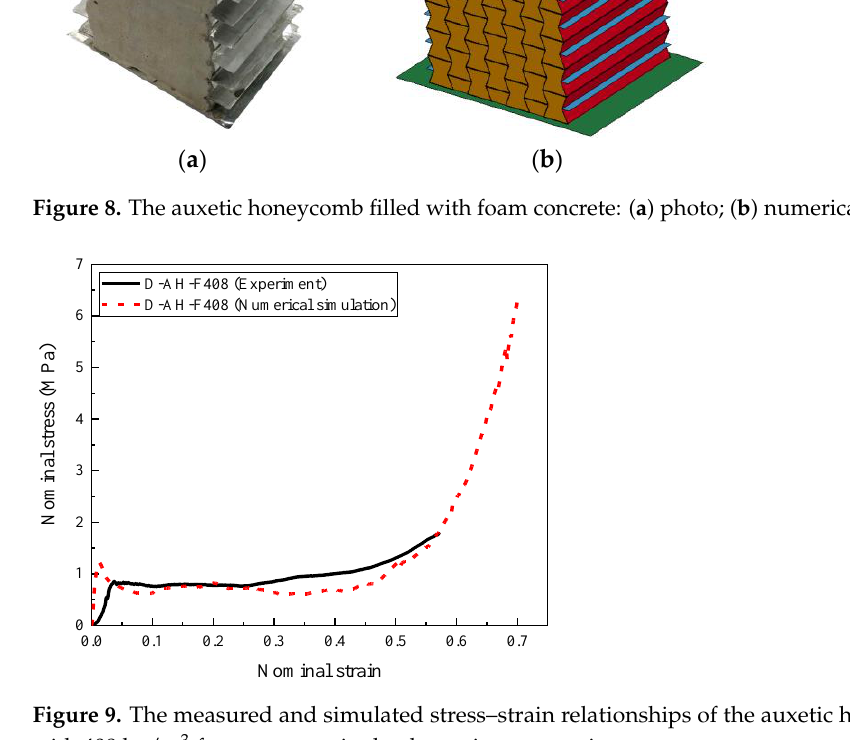
with 408 kg/m 3 foam concrete in the dynamic compression